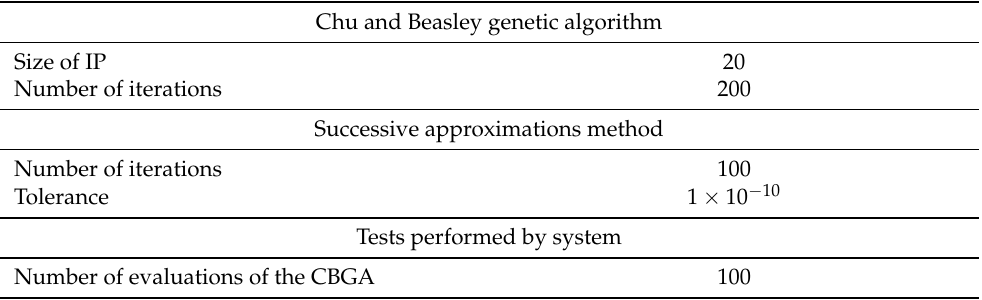
Table 2. Criteria used for Chu and Beasley genetic algorithm (CBGA) implementation. Chu and Beasley genetic